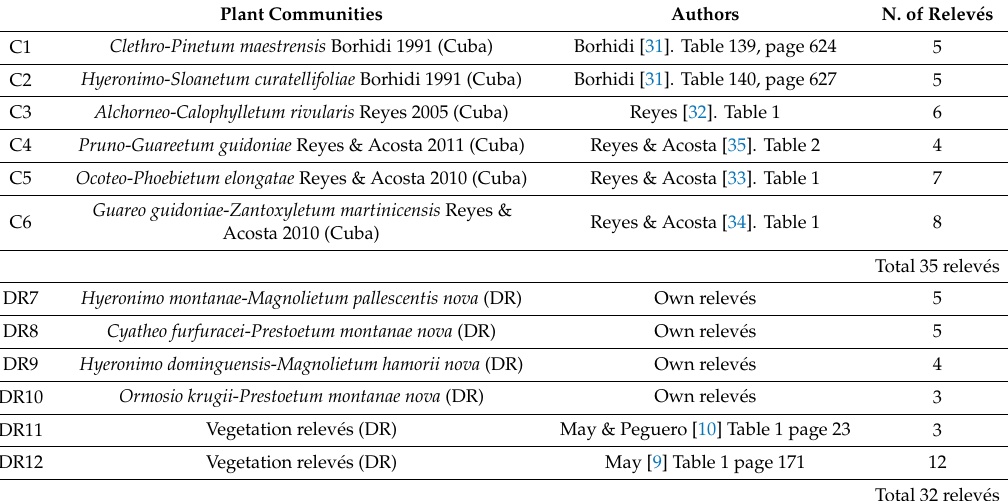
Table 6. Plant communities studied and number of relev é s for